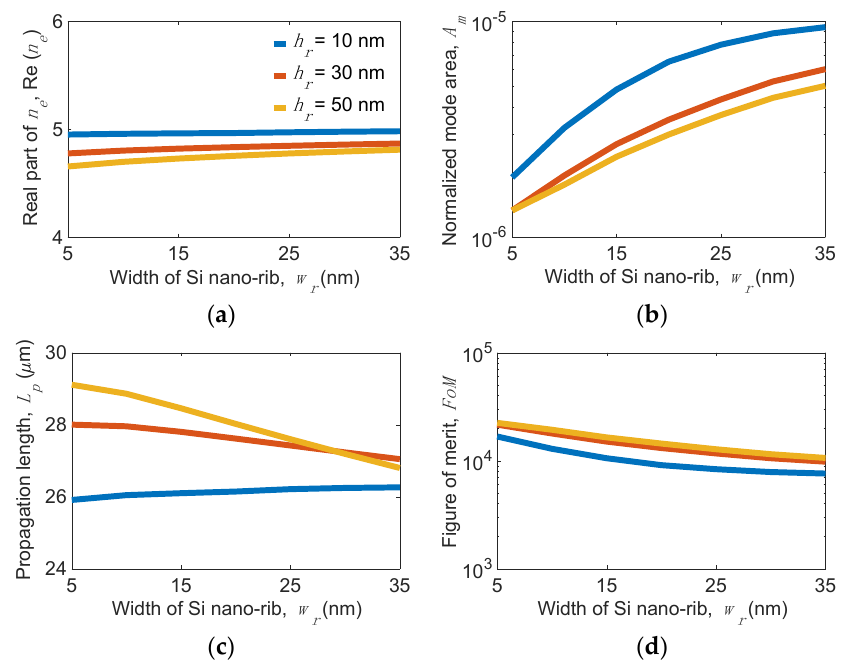
Figure 8. ( a ) Real part of effective index n e , Re( n e ), ( b ) normalized mode area, A m , ( c ) propagation length, L p , and ( d ) figure of merit, FoM of the present structure versus the width of Si nano-rib, w r for different height of Si nano-rib, h r values at the width of MLGMTs, w g = 200 nm , thickness of the bottom Si layer, t Si = 5 nm , and thickness of dielectric layers of MLGMTs, t d = 5 nm.